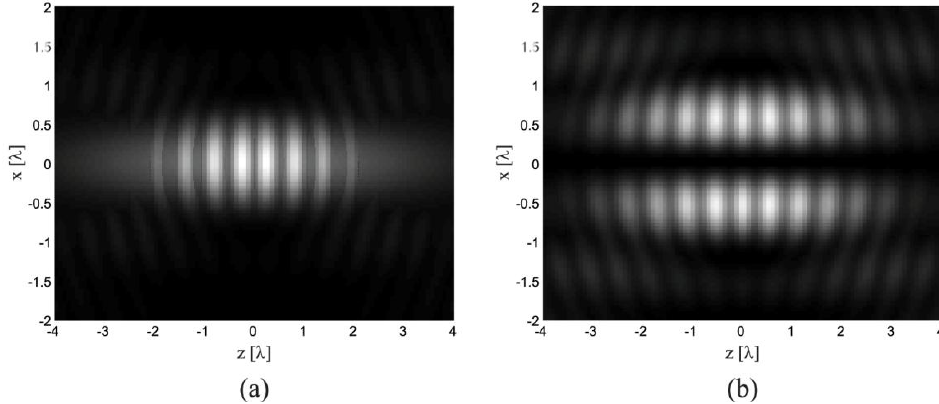
( a ) transverse and ( b ) longitudinal components. The gray scale indicates an increment of